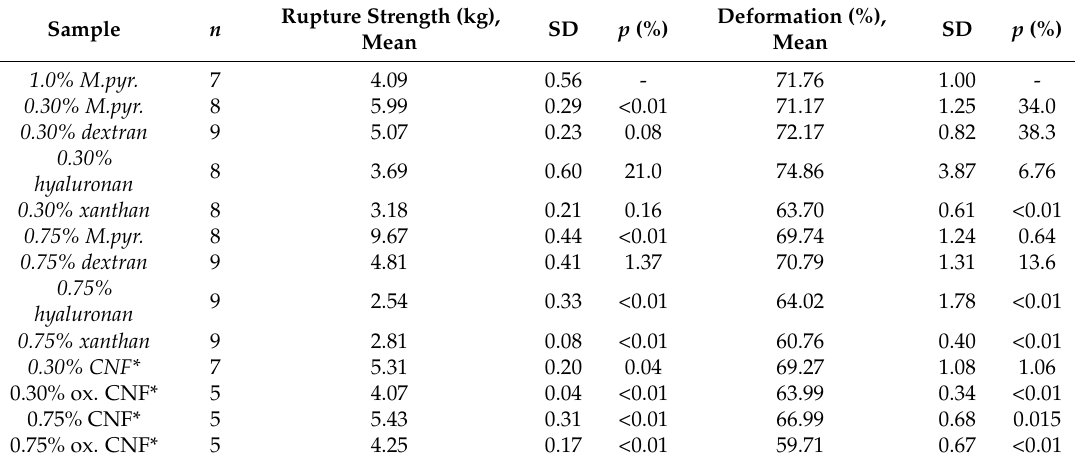
Table A6. Statistical outcomes, Figure 4C,D: Statistical outcomes, Figure 4: E = Young’s modulus, standard deviation (SD), number of samples ( n ), and p -value ( p ) of samples compared to the 1.0% alginate sample for other polymers CNF. P -values for CNF (*) are comparisons to the respective dry weight concentrations of alginate (1.30% and